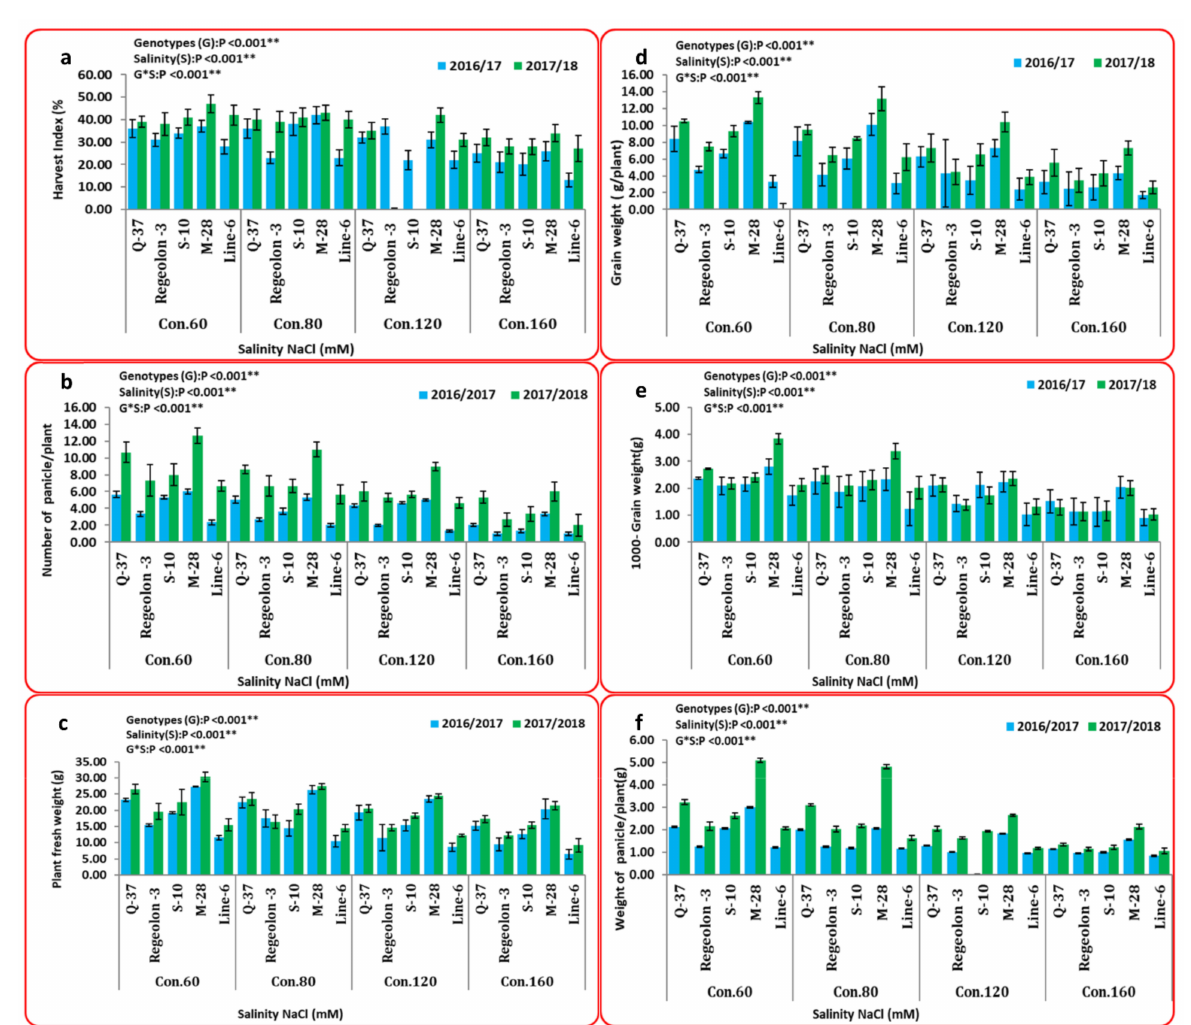
Figure 3. Mean performance (combined data of two seasons) represented as (mean ± SD) for yield and its component traits: ( a ) harvest index (HI; %), ( b ) number of panicles/plants, ( c ) plant fresh weight (g), ( d ) grain weight (g/plant), ( e )1000-grain weight (g) and ( f ) weight of panicles/plant (g). All data are means of three replicates. Two-way ANOVA was performed to test the effect of different quinoa genotypes on the studied traits. For all statistical tests, p values ≤ 0.01 ** were considered highly statistically significant.at 0.01% probability